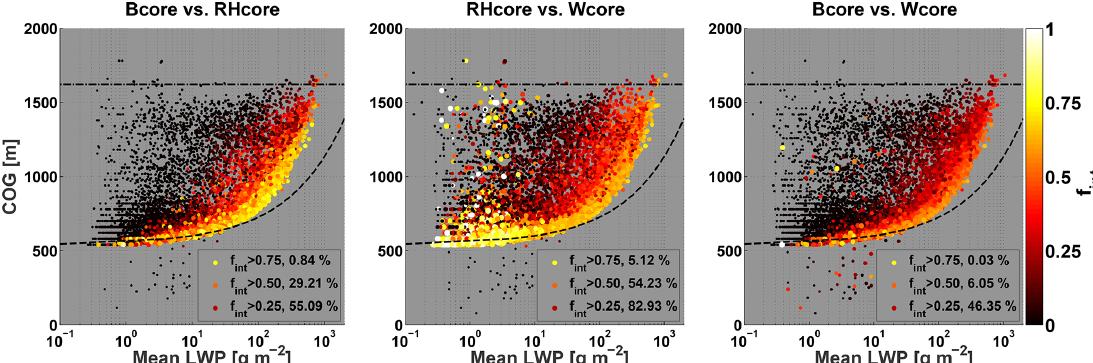
Figure 6. CvM phase-space diagrams of degree of interchangeability ( f int ) for each of the core pairs (as indicated in the panel titles). Bright colors indicate high values (cores can be interchanged with little effect), while dark colors indicate small values (no overlap between cores). Only clouds with a core by at least one definition are considered. Scatter point size is proportional to the minimum f vol of the core pairs in question. Panel legends include percentage of points (out of the scatter) with f int above a certain